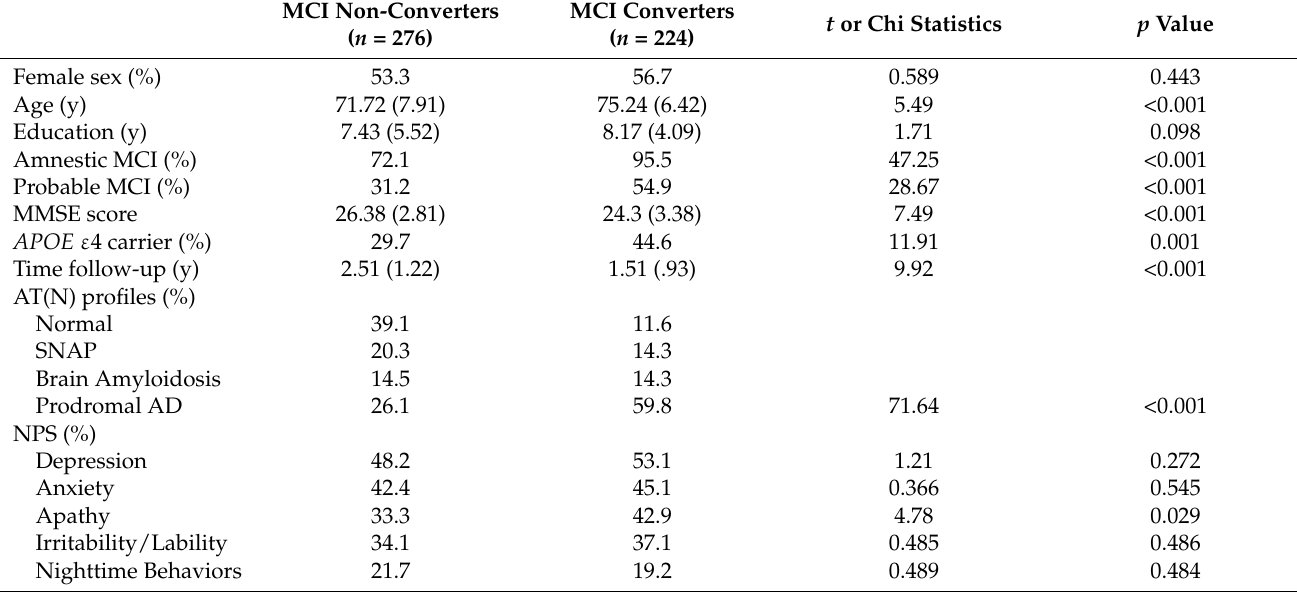
Table 4. Demographic and clinical overview of MCI non-converters vs. MCI converters.